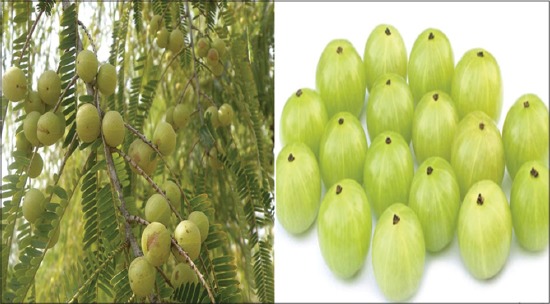
Photograph showing fruits of Phyllanthus emblica (Amla).